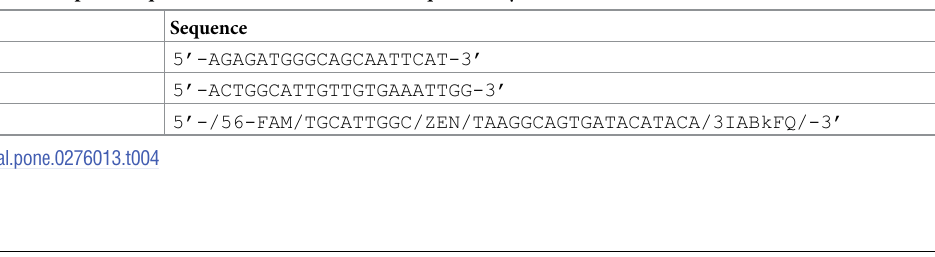
Table 4. RSV primer sequence and probe sequence for PrimeTime ™ standard qPCR assay.